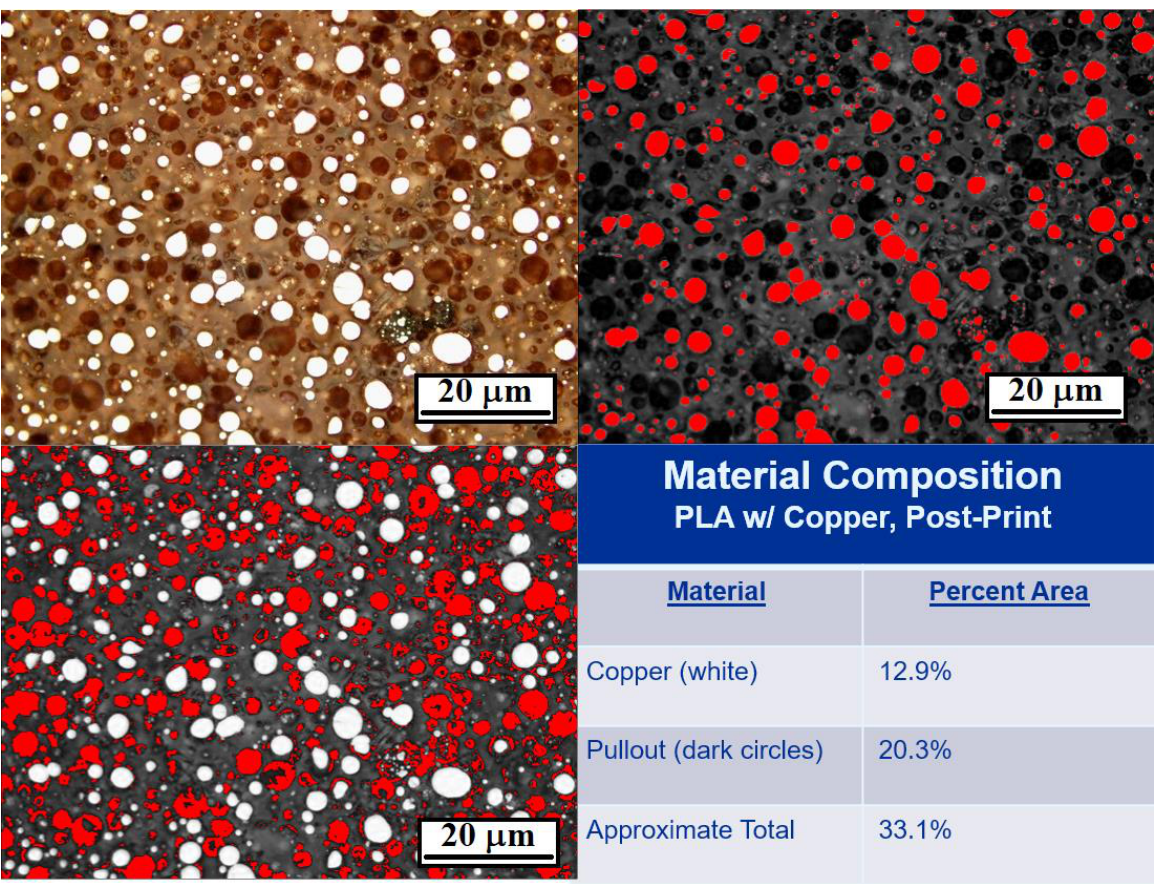
Figure 6. Area% calculation of Cu- PLA (post-print) where bright white spots (metal particles) are added with dark spots (pullout locations) to obtain total area% particles (performed with ImageJ).